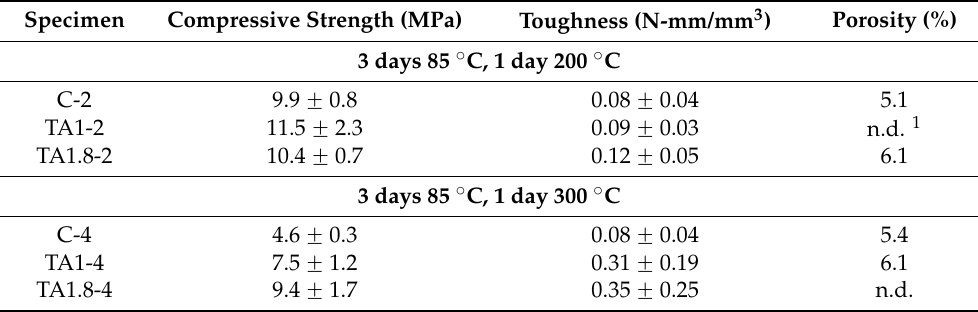
Table 3. Compressive strength, toughness, and porosity of control- and retarded- TSRC specimens.